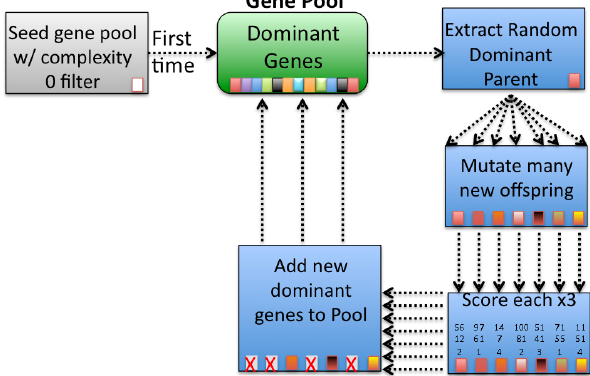
Figure 4. The genetic algorithm (GA) cycle. A parent is selected from the dominant gene 2 Fig. 4. The genetic algorithm (GA) cycle. A parent is selected from pool, mutated into thousands of offspring, and any new dominant solutions are added back 3 the dominant gene pool, mutated into thousands of offspring, and into the pool while the others are discarded. This cycle can be run massively in parallel, with 4 any new dominant solutions are added back into the pool while the each process contributing to the same ever-improving gene pool. 5 others are discarded. This cycle can be run massively in parallel, with each process contributing to the same ever-improving gene